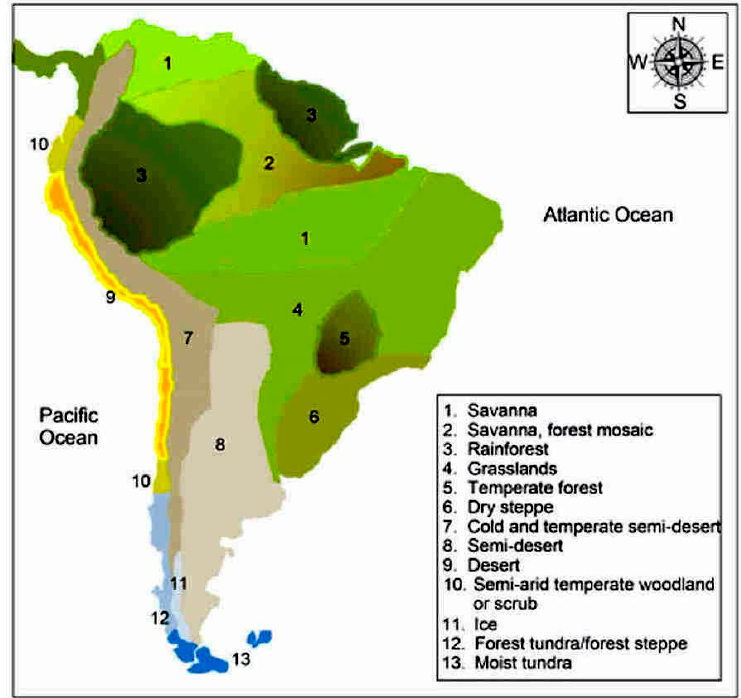
Figure 17. Map of the ecological regions in South America at the Pleistocene–Holocene transition (based on [106] and [107], and modified after Figure 2 of [109].